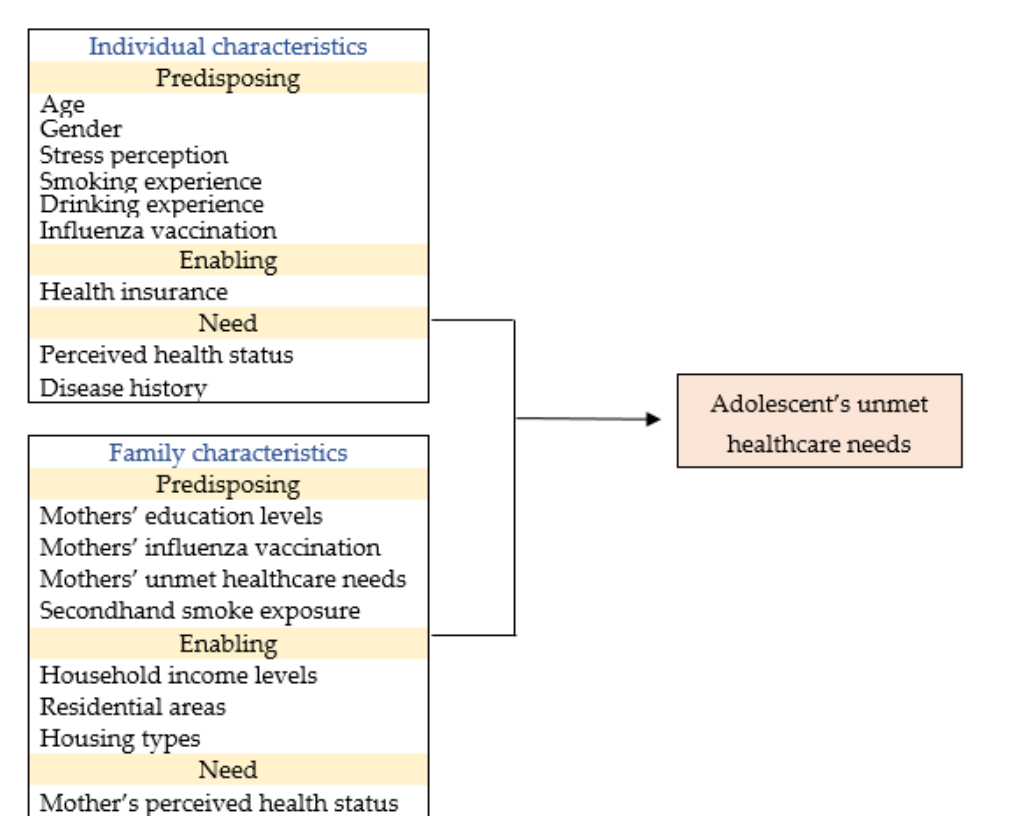
Figure 2. Conceptual framework for the current study, based on Andersen’s Behavioral Model of Health Services. Note: Adapted from “Societal and individual determinants of medical care utilization in the United States” by Andersen, R.; Newman, J.F. 2005, The Milbank Qquarterly, 83, p20 (doi: 10.1111/j.1468-0009.2005.00428.x) [18].